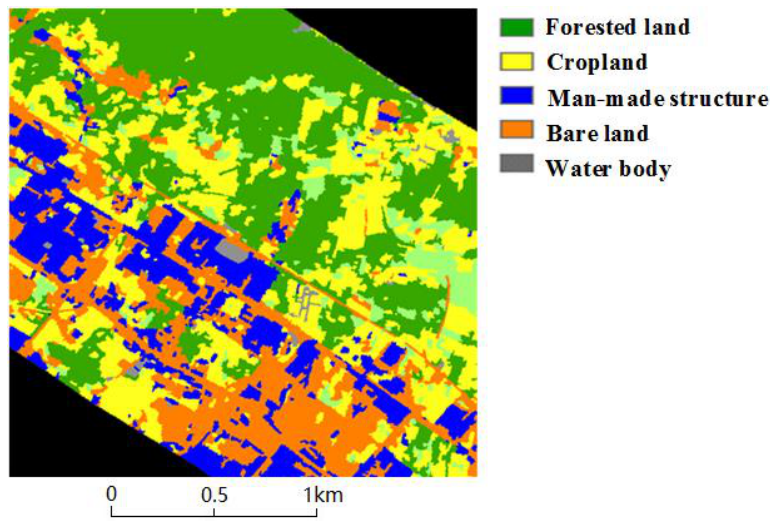
Figure 2. An output map of classification in one part of the high-voltage power line corridor.